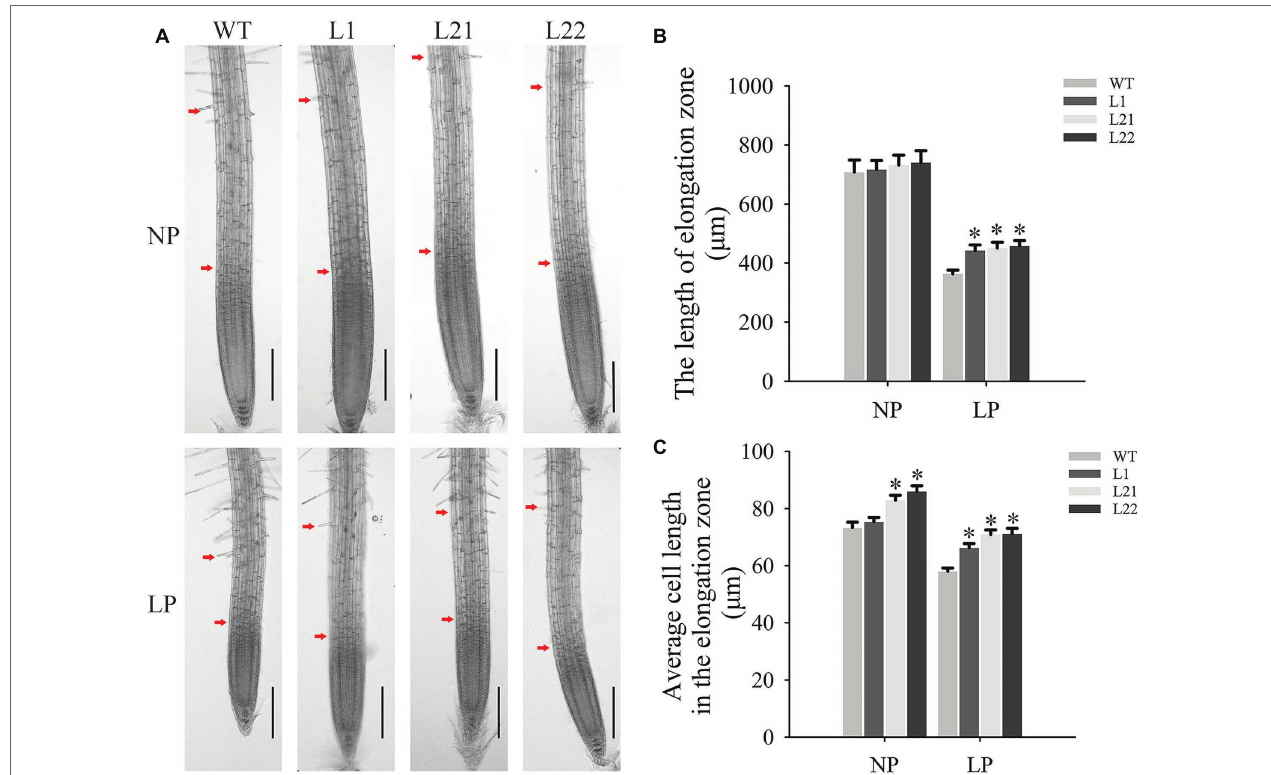
FIGURE 8 | Microscopic observation and measurements in the elongation zone of transgenic plants. (A) Microscopic observation of transgenic and wild-type plants under NP and LP conditions. The distance between the two red arrows represents the elongation zone. The scale bar = 200 μm. (B) The elongation zone length in transgenic and wild-type plants under the NP and LP conditions. The data are the mean ± SE ( n = 5). Error bars represent the SE. Asterisks indicate that the values are significantly different ( p < 0.05). (C) The cell length in the elongation zone in transgenic and wild-type plants under NP and LP conditions. The data are the mean ± SE ( n = 150). Error bars represent the SE. Asterisks indicate that the values are significantly different ( p <